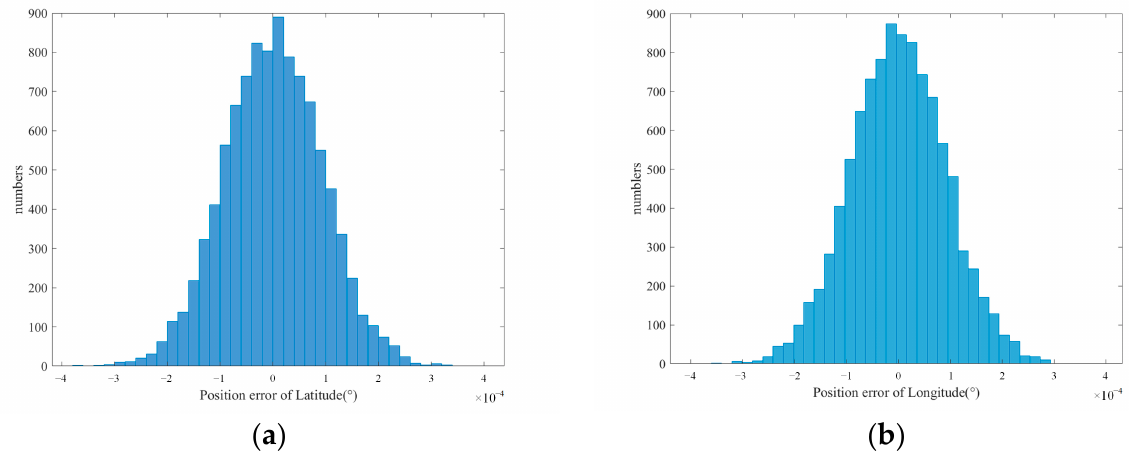
Figure 8. Probability distribution of longitude and latitude error. ( a ) Latitude error distribution; ( b ) Longitude error distribution.